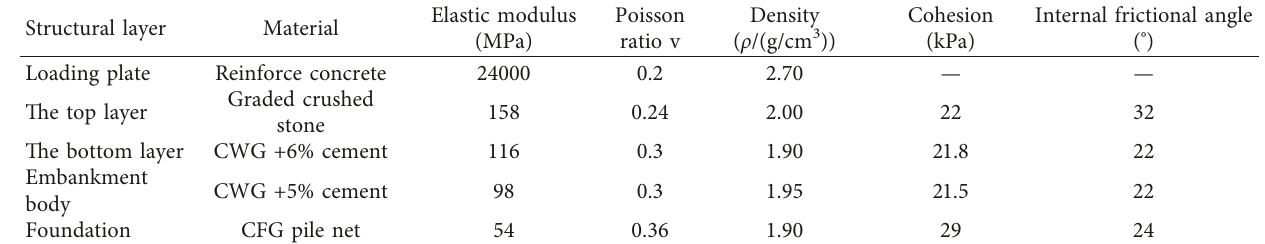
Figure 7: Variations of dynamic responses of the improved CWG with embankment depth. (a) Dynamic stress. (b) Dynamic displacement. Table 3: Material parameters of each structural layer.